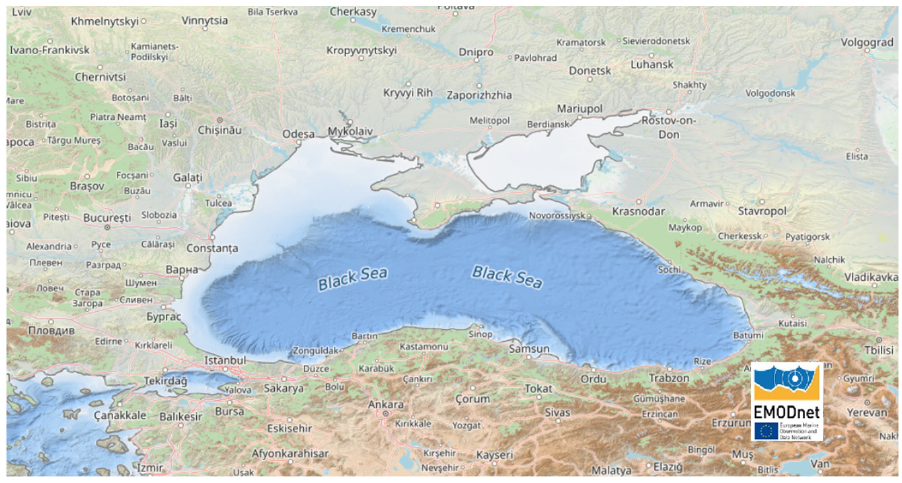
Figure 1. The Black Sea. Image obtained from [25].